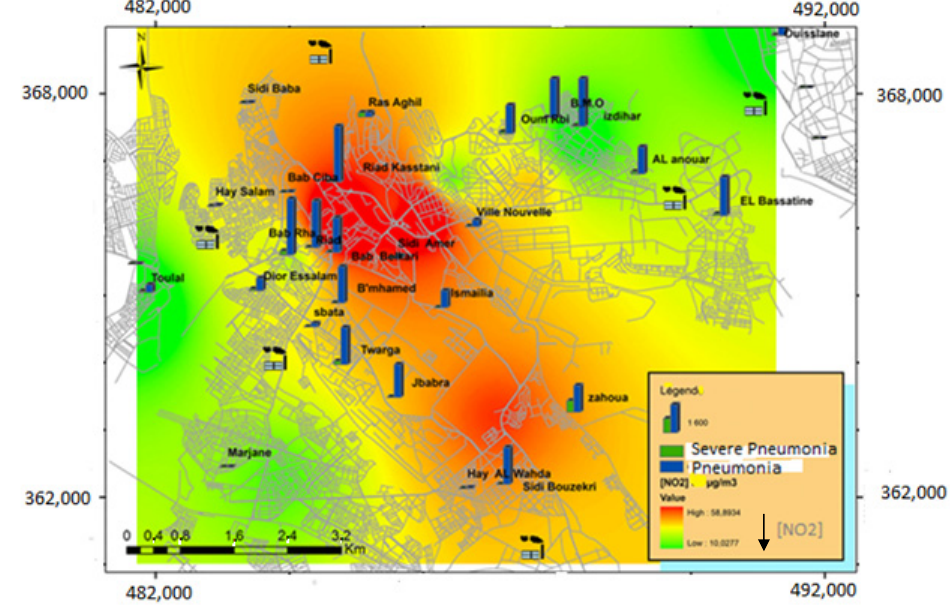
Figure 10. The average annual incidence of respiratory infection consultations (pneumonia and severe pneumonia) by health center as a function of nitrogen dioxide